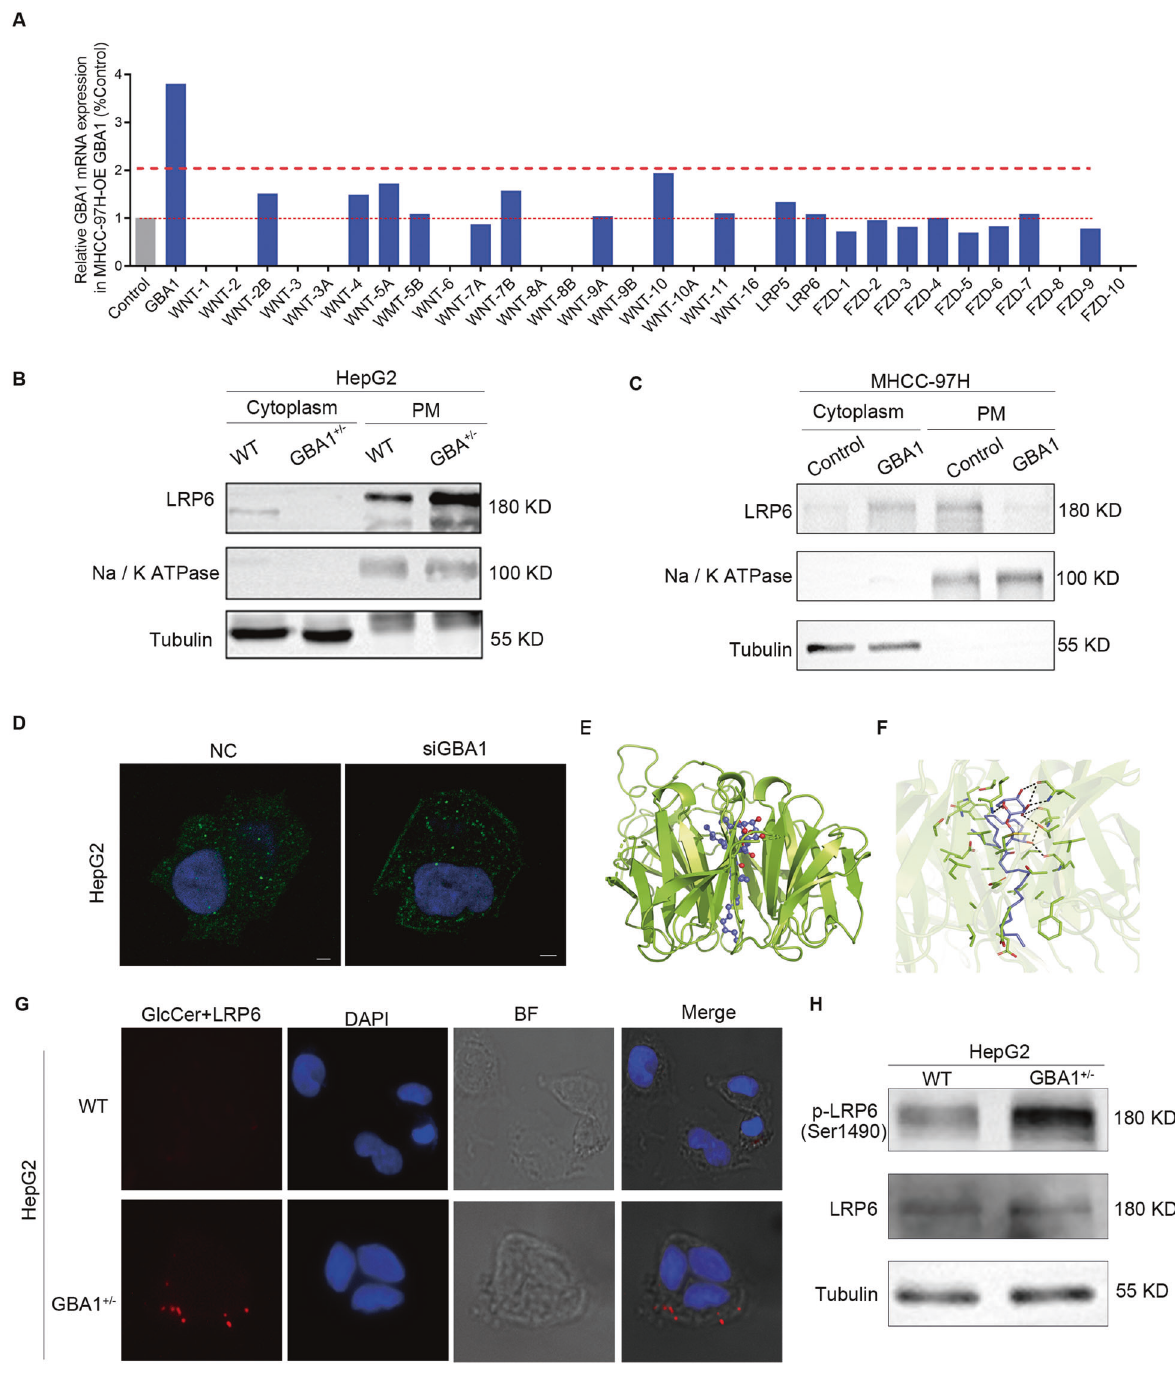
Fig. 5 Low expression of GBA1 increases the levels of LRP6 in the cell plasma membrane and led to an interaction between GlcCer and LRP6. A Real-time quantitative RT-PCR analysis of Wnt molecules and Wnt receptors, including FZD1-10 and LRP5/6 mRNA, in MHCC-97H cells with stable GBA1 overexpression. B , C Western blotting was performed to determine the levels of LRP6 in the cytoplasm and plasma membrane in HepG2 cells with stable GBA1 downregulation and in MHCC-97H cells with stable GBA1 overexpression. D Immuno fl uorescence staining was used to detect the location of LRP6 in the plasma membrane after GBA1 was knockdown in HepG2 cells. scale bar, 10 μ m. E , F Schematic representation of the binding mode of GlcCer and YWTD-EGF Domain Pair (PDB code: 1IJQ) of LRP6, Autodock was employed for docking and PyMOL was used for graph preparation. G An interaction of endogenous GlcCer and LRP6 was detected by PLA in HepG2 cells with stable GBA1 downregulation. BF: bright fi eld. H Western blotting was performed for the phosphorylation of LRP6 at Ser1490 in HepG2 cells with stable GBA1